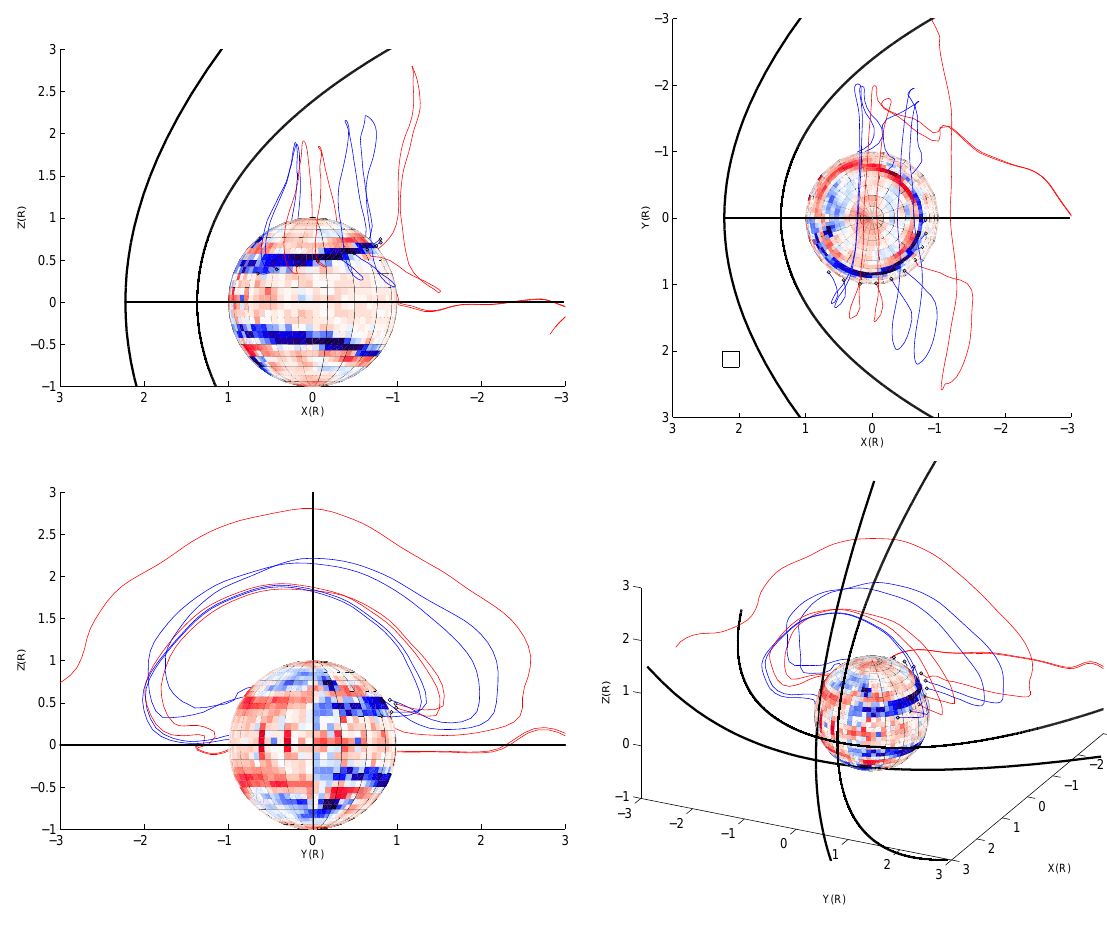
Fig. 3. Current lines starting from the ionosphere for run 1. The same lines are shown from four viewpoints. The starting points are selected in the duskside where significant current flows out of the planet. Lines returning to the planet are shown as blue and lines hitting the simulation box outer boundary are shown in red. To guide the eye, roughly estimated bow shock and magnetopause positions are shown as black